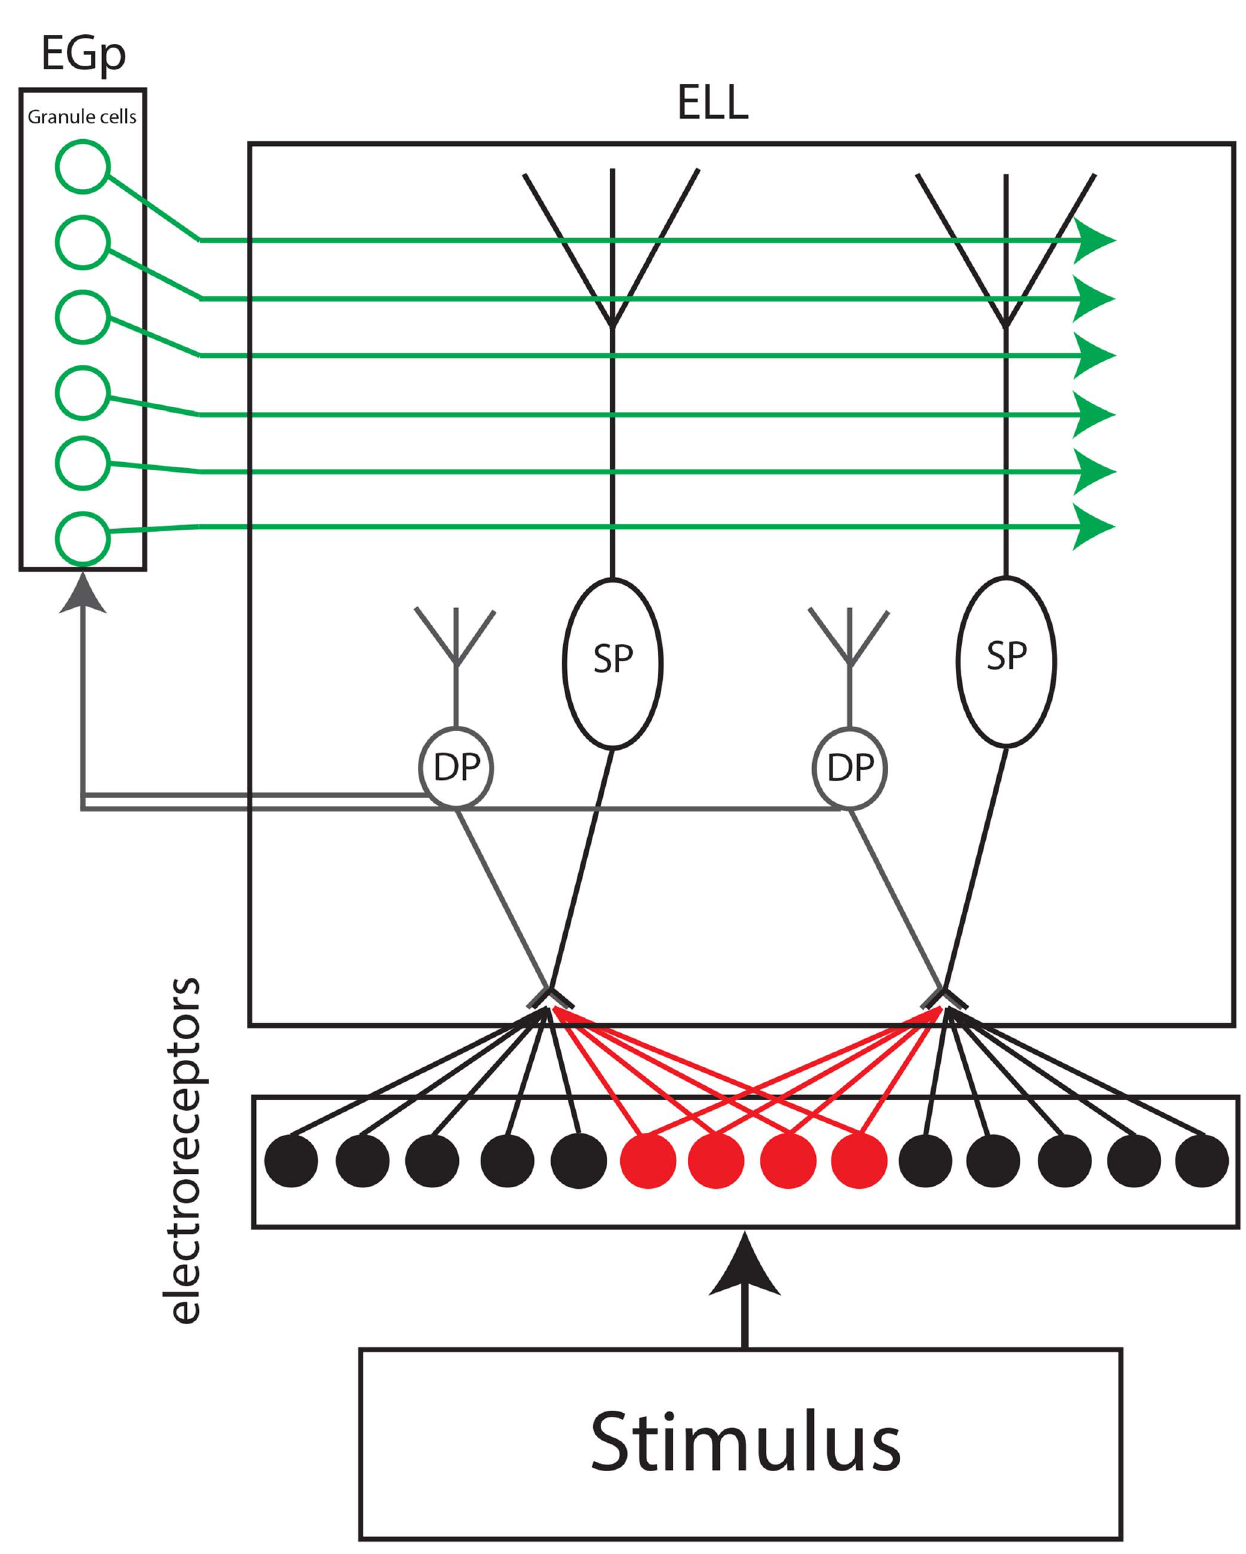
Fig. 1. Anatomical and model schematic. Peripheral electroreceptor afferents receive the sinusoidal stimulus and project to both deep pyramidal (DP) as well as superficial pyramidal (SP) cells. The DPs relay the stimulus faithfully to a set of granule cells within the Eminentia Granularis posterior (EGp) that make direct excitatory synaptic contact onto SPs via parallel fibers as well as indirect inhibitory synaptic contact via local interneurons. It is assumed that each granule cell responds to a given phase of the sinusoidal stimulus and project via excitation and inhibition to SPs.